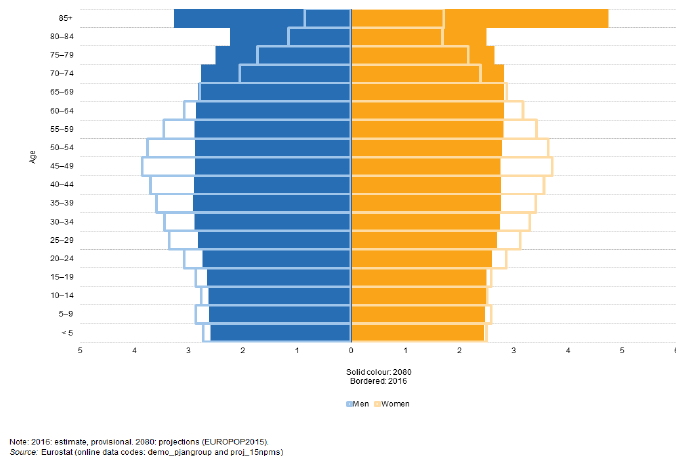
Source: Eurostat,